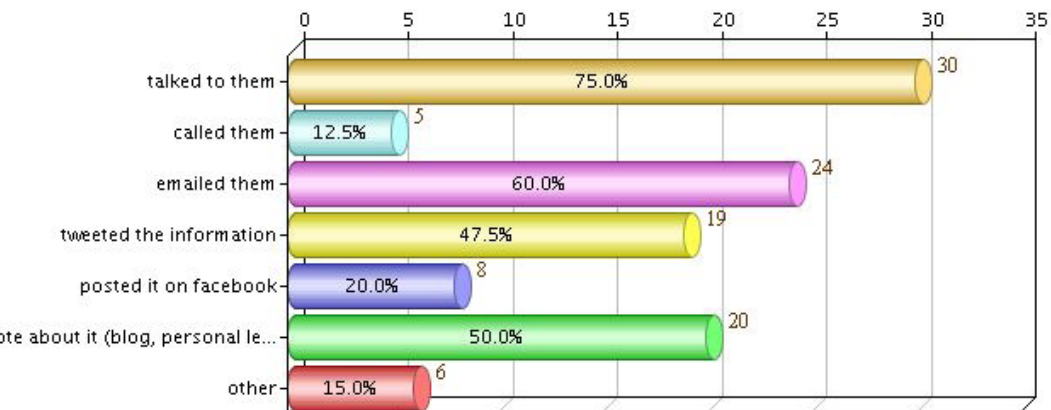
Figure 12 . If you shared information with others, how did you share it? ( N = 40).